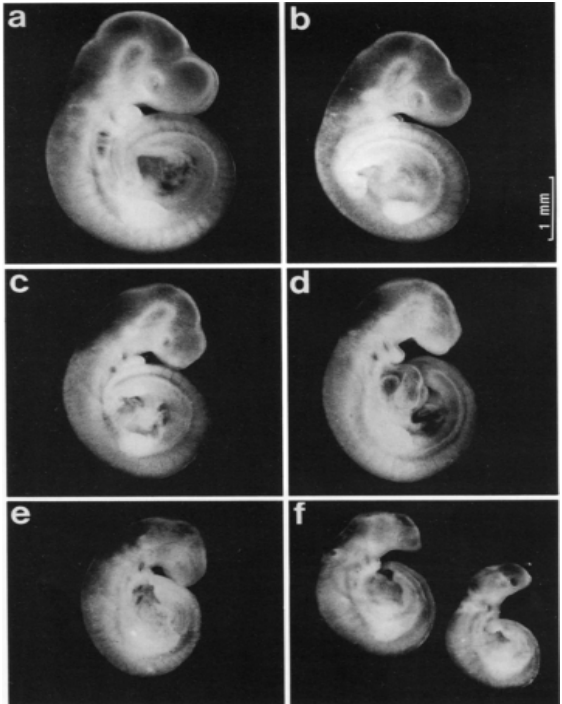
Figure 2. The 11.5-day-old rat embryos after maternal treatment with ( a ) 3 × 0.1 N NaOH (5 mL/kg) on day 10 of gestation (control); ( b ) 8 × ACV (50 mg/kg body wt) from day 9 (7:00) to Day 11 (12:00) of gestation; ( c ) 2 × ACV (100 mg/kg body wt) on day 10 (7:00 and 12:00) of gestation; ( d ) 1 × ACV (200 mg/kg body wt) on day 10 (7:00) of gestation; ( e ) 3 × ACV (100 mg/kg body wt) on day 10 (7:00, 12:00, 17:00) of gestation; ( f ) 8 × ACV (100 mg/kg body wt) from day 9 (7:00) to Day 11 (12:00) of gestation (reproduced with permission [46], copyright 1991, Springer Nature).